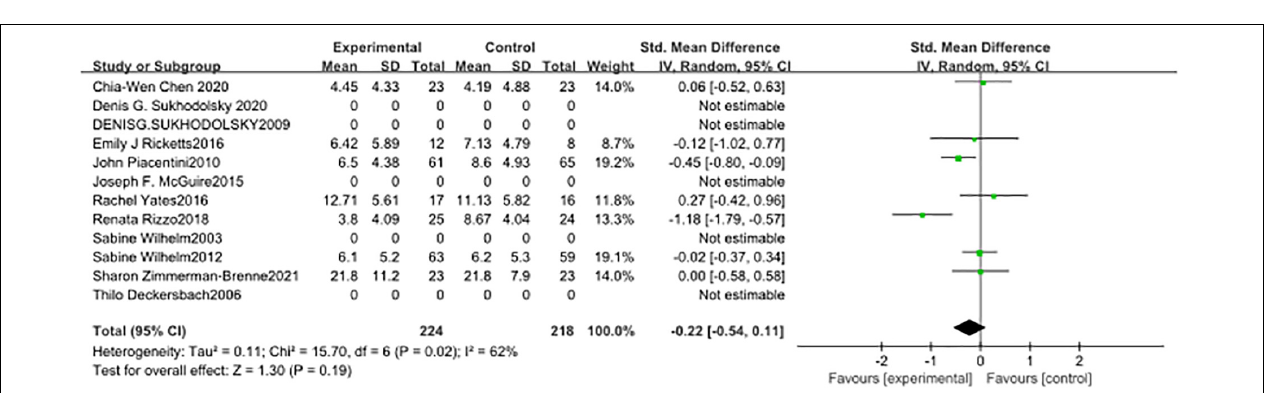
FIGURE 6 | Forest plot of the effect of cognitive-behavioral therapy (CBT) treatment groups vs. control groups on the vocal tic